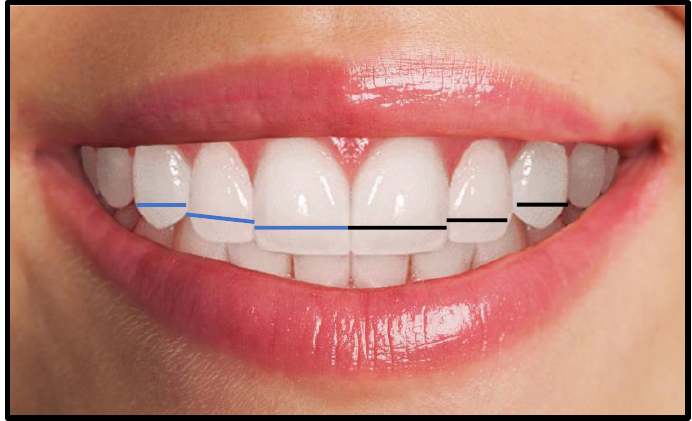
Figure 1. The measurements of 2-D photographic mesiodistal maxillary anterior teeth width. The blue line (right maxillary quadrant), black line (left maxillary quadrant).